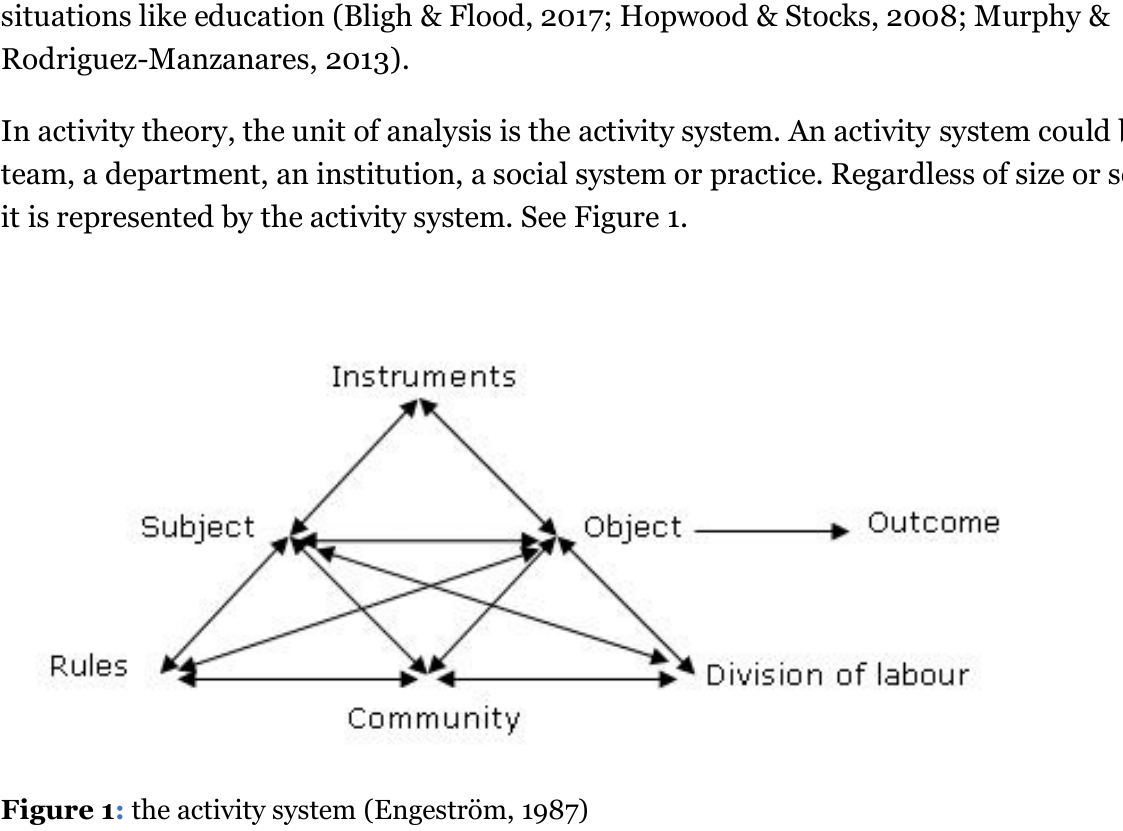
Figure 1: the activity system (Engeström, 1987)